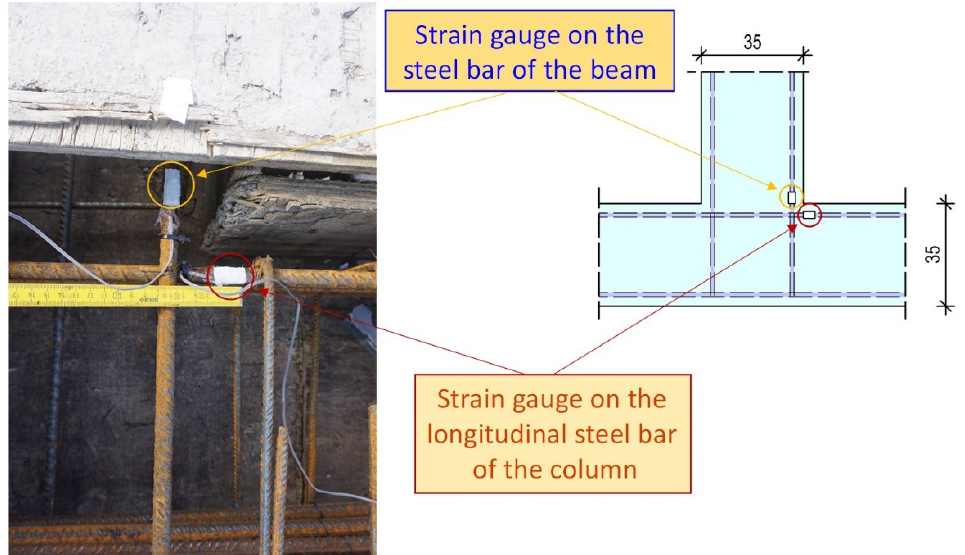
Figure 11. Strain gauges were bonded on the steel reinforcing bars of the beam and the column at the edge of the joint body panel of each specimen.